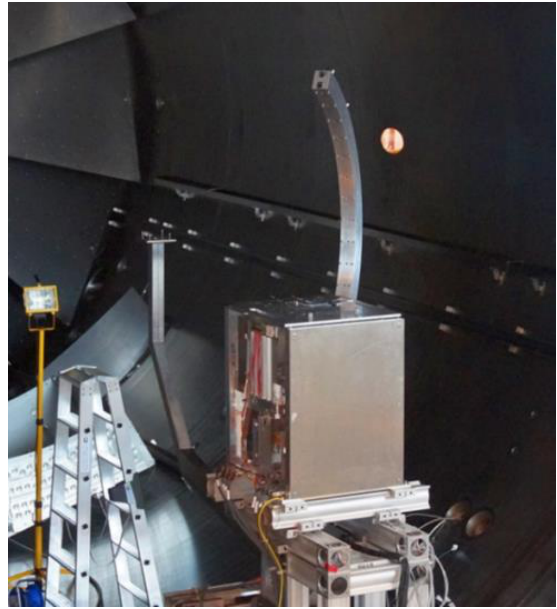
Figure 4: Beam diagnostics systems. On the left the single plane arm, and in the middle of the photo, the multi-sensor arm can be seen.